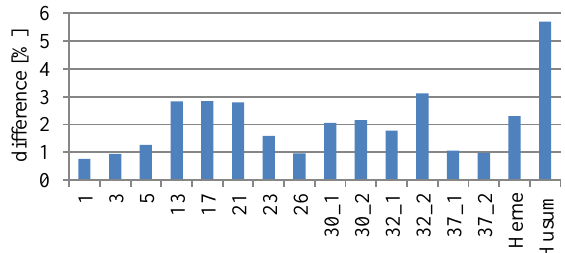
Figure 9. Median of absolute differences between the estimated and the true elements of the transition matrix